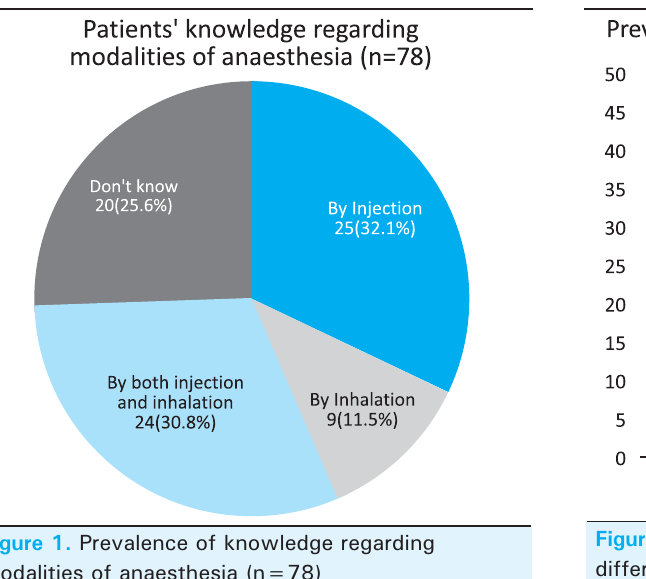
Figure 2. Prevalence of fear of anaesthesia in different age groups in